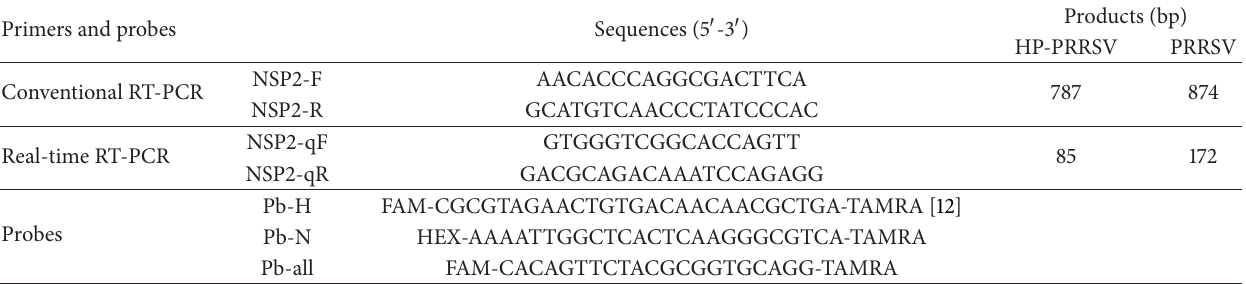
Table 1: Primers and probes used in the real-time RT-PCR and conventional RT-PCR